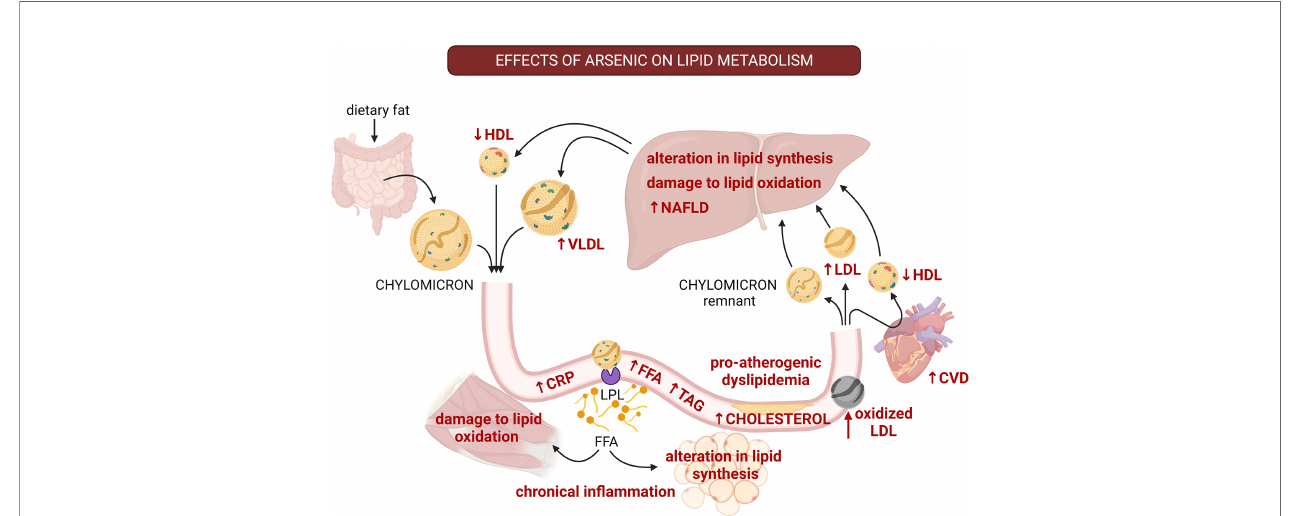
FIGURE 3 | The multiple effects of arsenic on lipid homeostasis and the progress to pro-atherogenic dyslipidemia. The effects of arsenic are shown with red font. Arsenic alters synthesis and oxidation of lipids in liver, promoting the development of non-alcoholic fatty liver disease (NAFLD). Also, arsenic diminishes HDL- cholesterol, and increases LDL-cholesterol, free fatty acids, and triglycerides, which are characteristics of pro-atherogenic dyslipidemia. Besides, arsenic promotes lipid peroxidation, which also promotes atherosclerosis. Arsenic exposure correlates with high levels of oxidized LDL and C-reactive protein (CRP) which contributes to systemic in fl ammation and alterations to lipid metabolism in other tissues. These alterations lead to insulin resistance and are a major risk factor for developing cardiovascular diseases. CVD, cardiovascular disease; CRP, C-reactive protein; FFA, free fatty acids; HDL, high-density lipoprotein; LDL, low-density lipoprotein; LPL, lipoprotein lipase; TAG, triglycerides; VLDL, very low-density lipoprotein. Created with